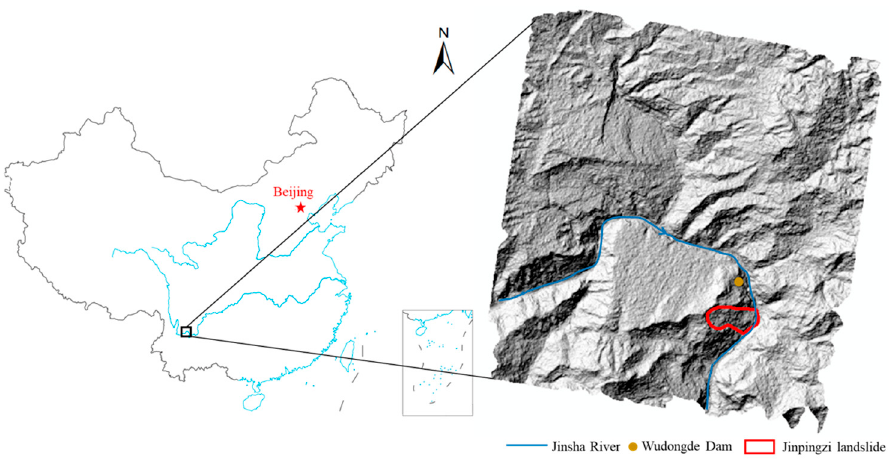
Figure 1. Location of the Jinpingzi landslide.